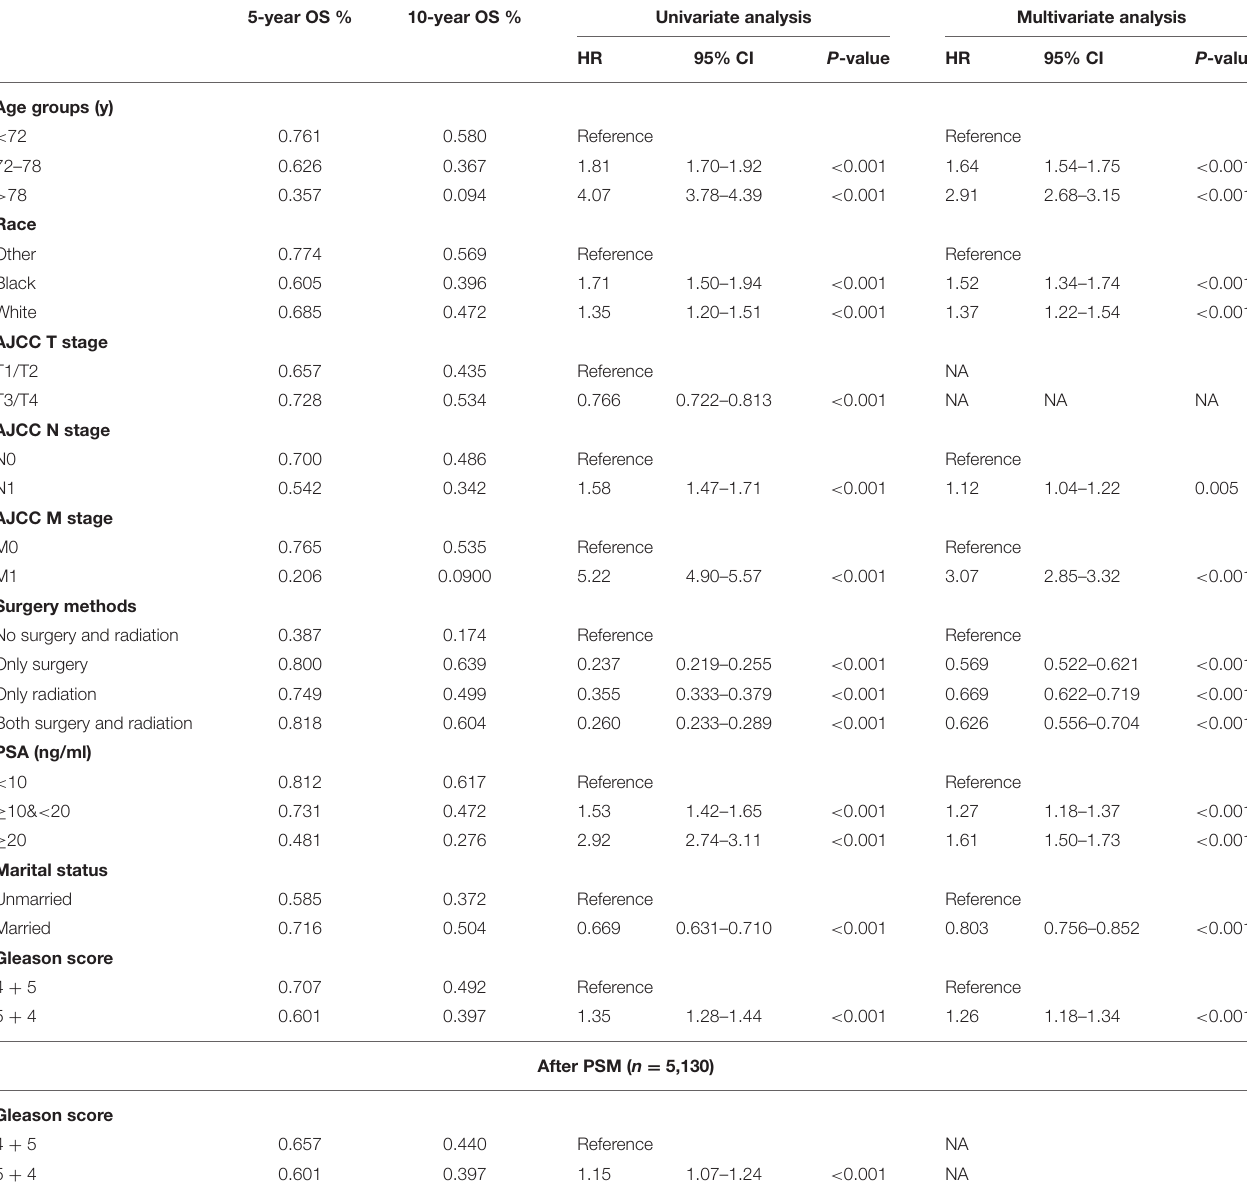
TABLE 2 | Univariate and multivariate Cox analyses of OS ( n = 10,124).